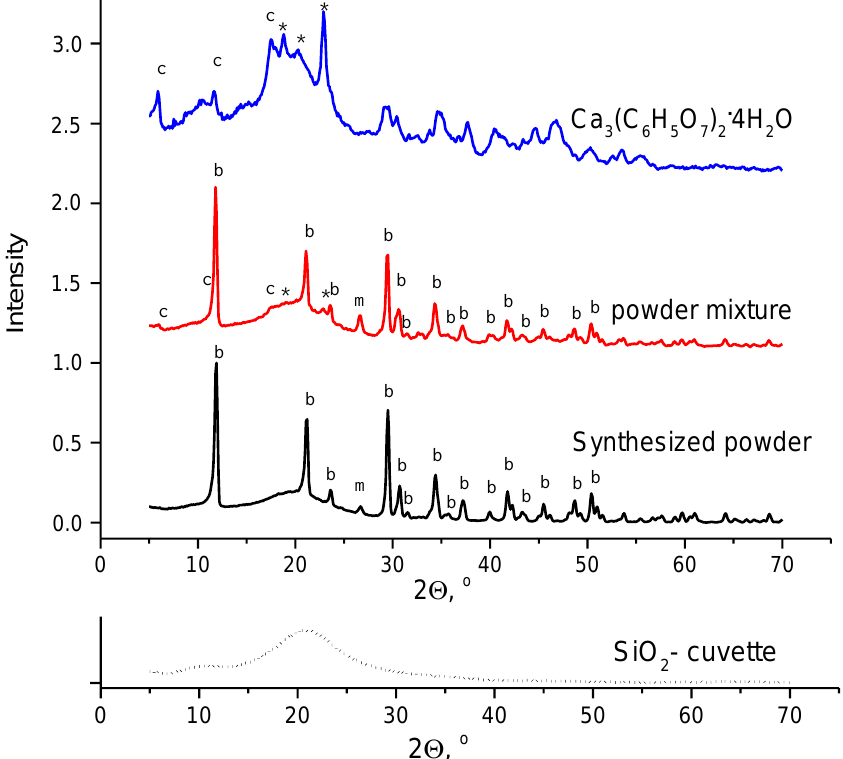
Figure 2. XRD data for synthesized powder (in black), calcium citrate tetrahydrate Ca 3 (C 6 H 5 O 7 ) 2 ·4H 2 O (in blue), and their powder mixture (in red); (c) — calcium citrate tetrahydrate Ca 3 (C 6 H 5 O 7 ) 2 · 4H 2 O (PDF card 25-1568), * — reflexes belonged to the XRD data for the calcium citrate tetrahydrate reagent, (b) — brushite CaHPO 4 ‧ 2H 2 O (PDF card 72-713), m — monetite CaHPO 4 (PDF card 71-1759).